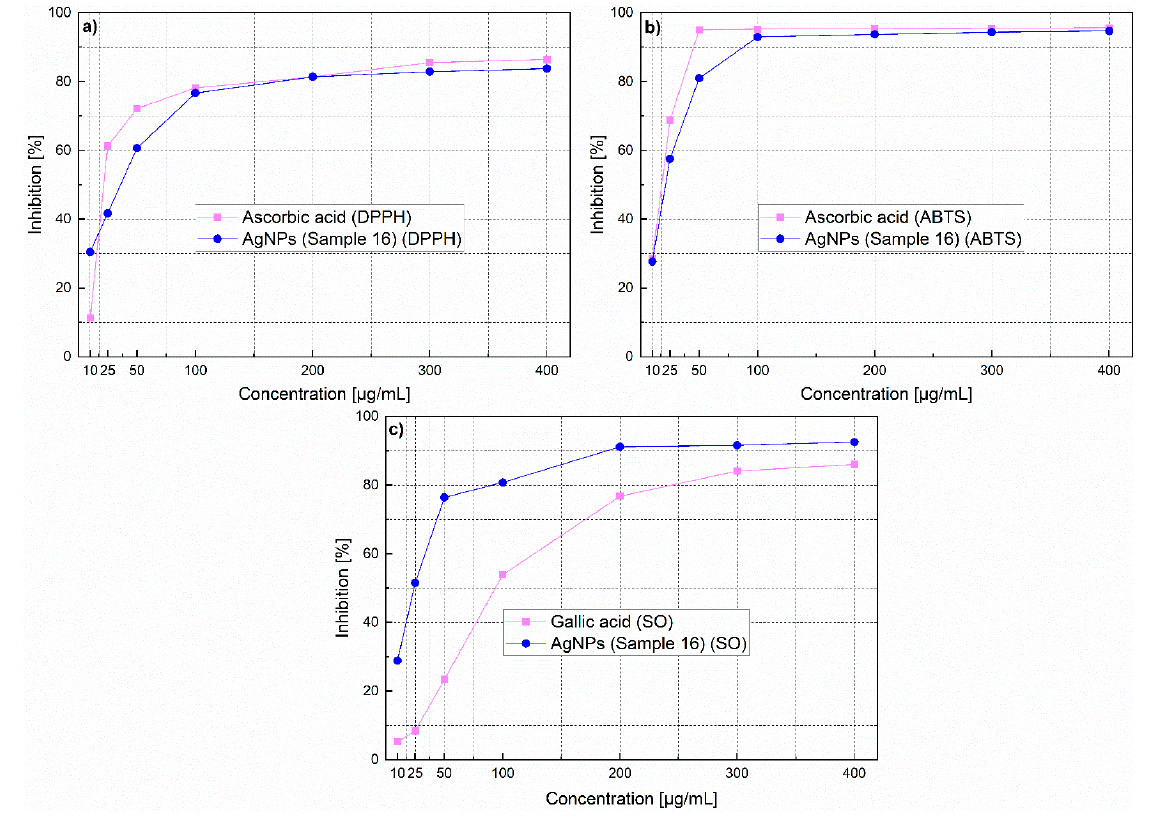
Figure 14. Antioxidant activity of AgNPs ( a ) DPPH free radical scavenging activity, ( b ) ABTS radical scavenging activity and ( c ) superoxide anion radical scavenging activity. 3.10. Determination of Time- and Dose-Dependent Cytotoxicity of Biosynthesized AgNPs In CTB test for evaluation of the cell viability, viable cells turn blue resazurin into pink resorufin generating a fluorescent signal, while nonviable cells cannot do that be- cause they lost their metabolic activity. Both, the influence of exposure time, and AgNPs dose were studied. The time ranged between 2, 5, 8 and 24 h, and the dose range of AgNPs synthesized utilizing St John’s wort extract was between 2.5 µg and 88 µg/mL. The range of viability observed for HeLa cells, Hep G2 cells, and A549 cells are shown in Figure 15a–